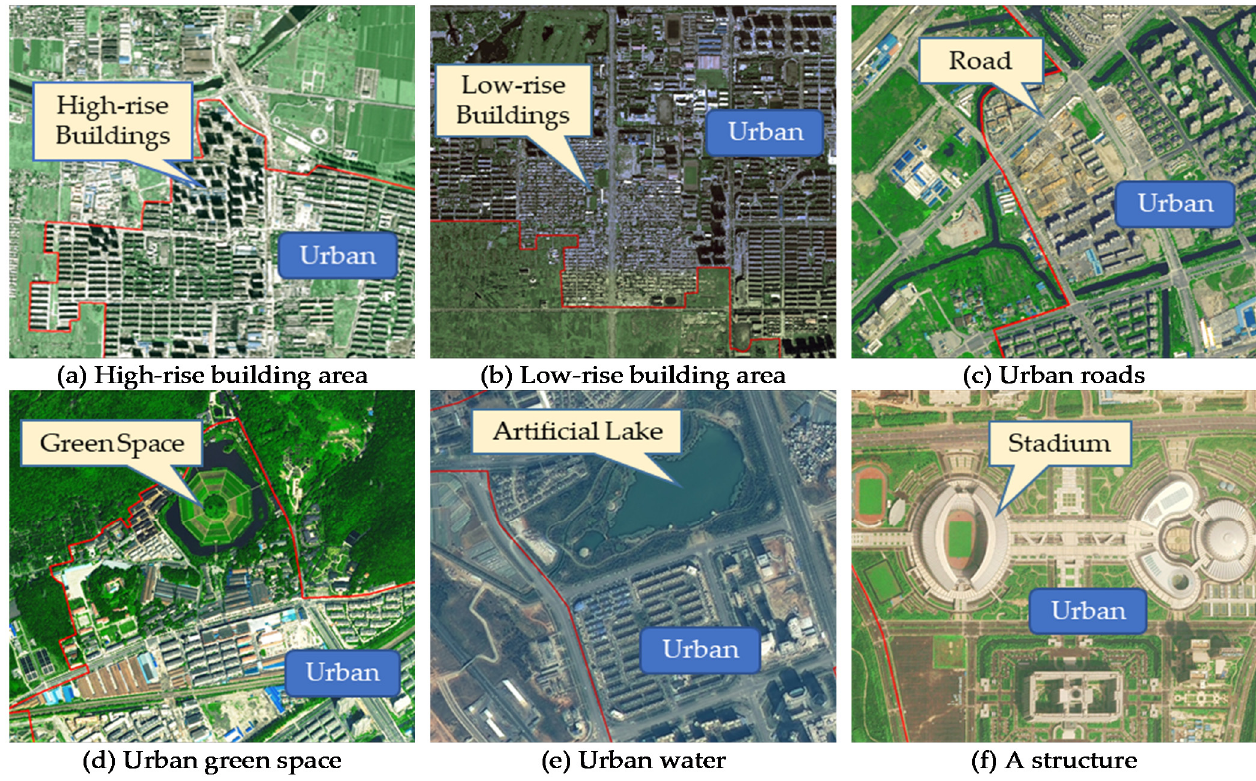
Figure 4. Examples of urban feature interpretation symbols in remote sensing imagery: ( a ) high-rise building area; ( b ) low-rise buildings area; ( c ) urban road; ( d ) green space near the edge of urban built-up area; ( e ) an example of urban water, namely an artificial lake; ( f ) an example of structure, namely a stadium. The red line in the figure represents the boundary of the urban built-up area.